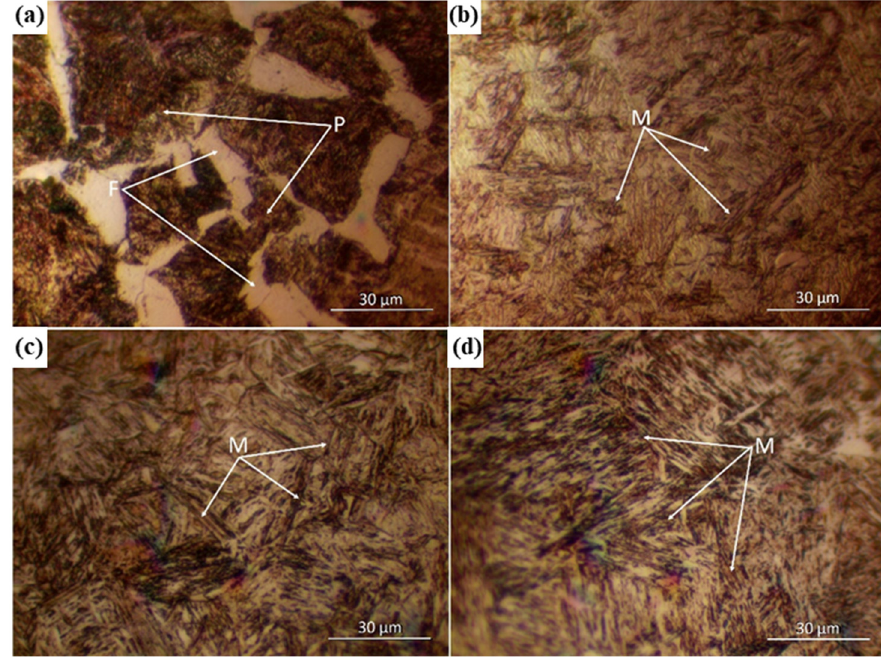
Figure 2. Optical micrographs of 40 Kh steel: ( a ) initial, ( b ) No.1, ( c ) No.2 and ( d ) No.3. Figure 3 shows the diffractograms of the original and hardened 40 Kh steel specimens which were evaluated by X-ray diffraction patterns using the software database, PowderCell 2.4. Diffractograms were taken from the active surface of the original and plasma hardened samples. The results show the presence of peaks corresponding to martensite. These results are in agreement with the microstructure study.